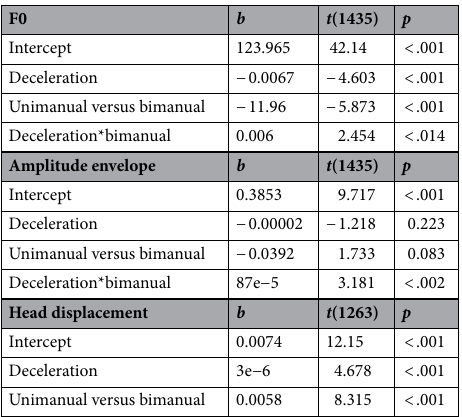
Table 3. Acoustics and head displacement in relation to physical impulse for the blind condition. Mixed regression models with F0, Amplitude Envelope, and Head displacement as DV’s, experiment (1998, 2002) as random intercept. We modeled bimanual (vs. unimanual) gesture together with gesture deceleration magnitude, and if reliable, the interaction between bimanual gesture and deceleration magnitude (this interaction was not reliable for head displacement). Results show that bimanual gesturing moderated the effect of gesture deceleration magnitude on acoustics (F0 and Amplitude Envelope), and a higher manual gesture deceleration magnitude was related to more concomitant head